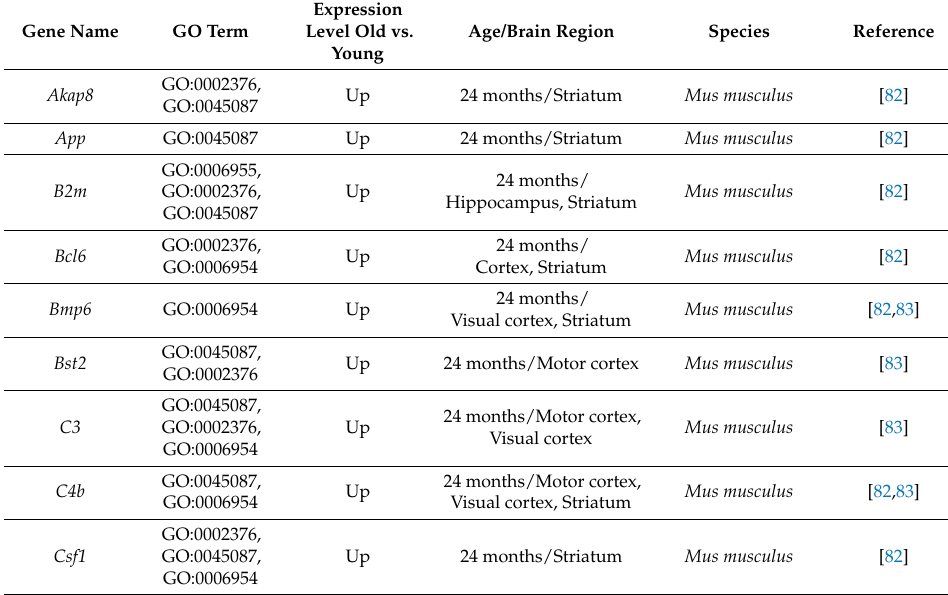
Table 2. List of DEGs associated with inflammation/immune response in aged